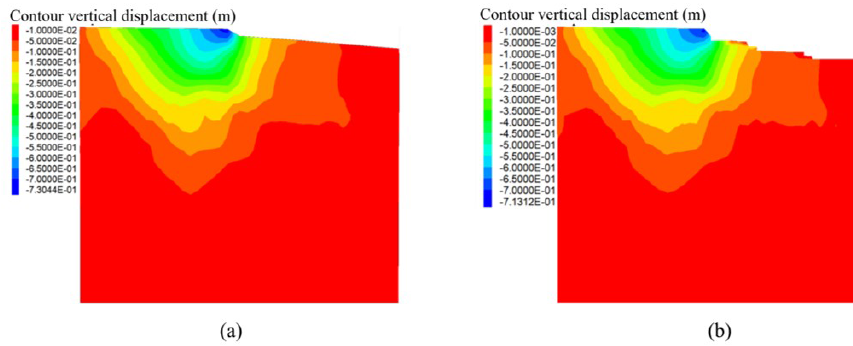
Figure 34. Vertical displacements contours in metres (a) after seismic loading and (b) after tsunami loading.